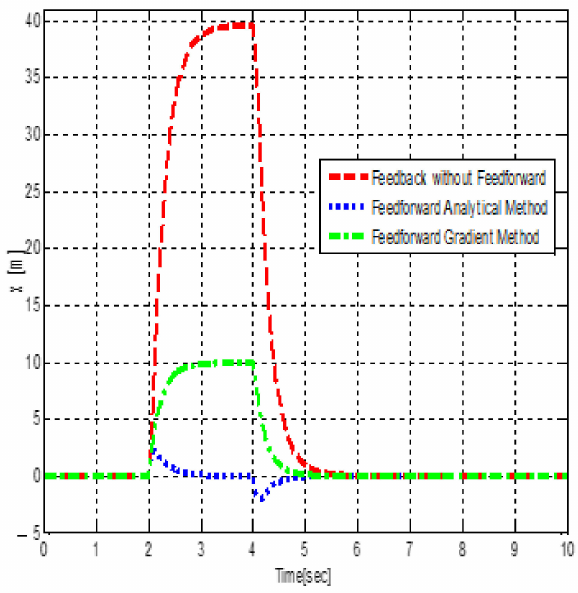
Figure 13. Drift facing constant wind.